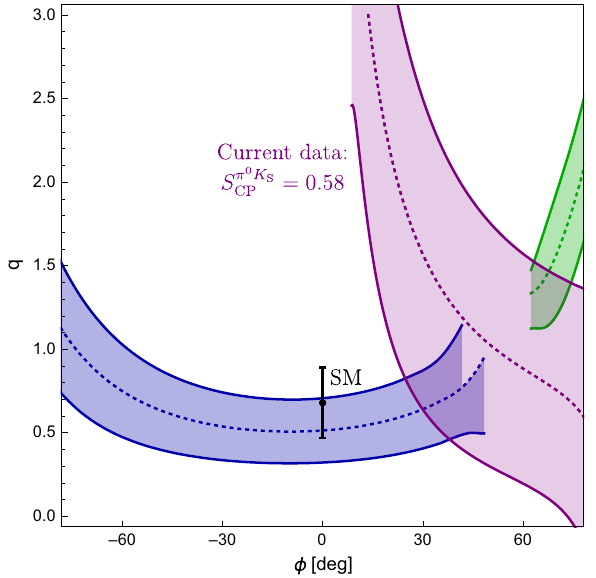
Fig. 13 Constraints on the EW penguin parameters q and φ from cur- rent data. The blue and green contours follow from the isospin analysis and are in agreement with the constraint from R c 4 ( tan φ − (γ + φ) + sin (γ + φ)) 00 cos 3